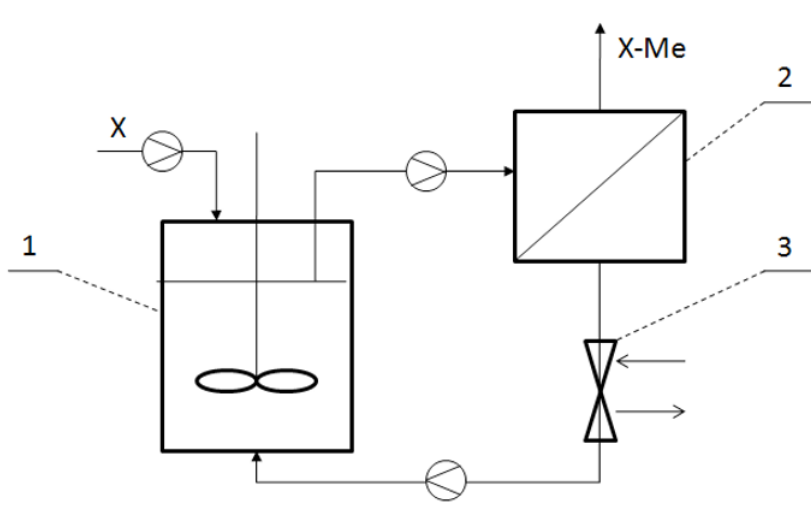
Figure 1. Flowchart of the production of mineral feeds additives based on algal biomass. (1): Reactor/biosorber (here the biosorption process takes place), (2): Filter (here the separation of the biomass from permeate takes place), (3): Valve